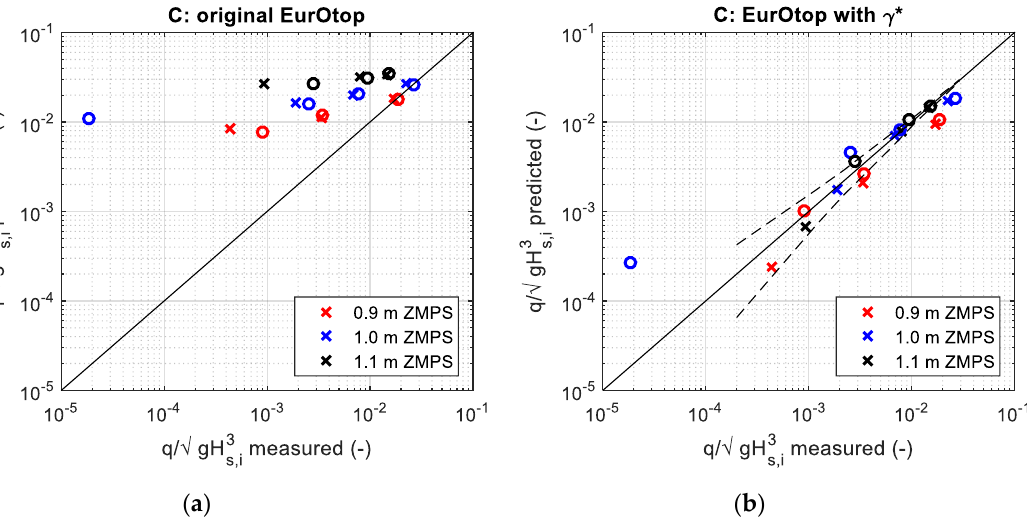
Figure 13. Measured overtopping and predictions for the cross-sections C: according to EurOtop ( a ), applying γ * ( b ). Crosses (x) are relative to S op = 0.063, circles (o) are relative to S op = 0.048. Dashed lines are the upper and lower 95% prediction bounds.